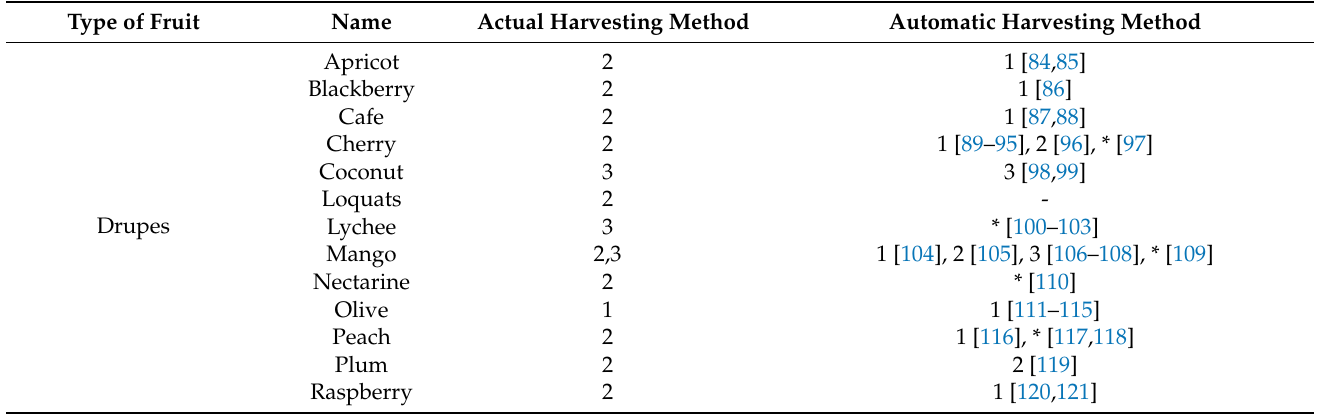
Table 2. Simple fleshy fruit